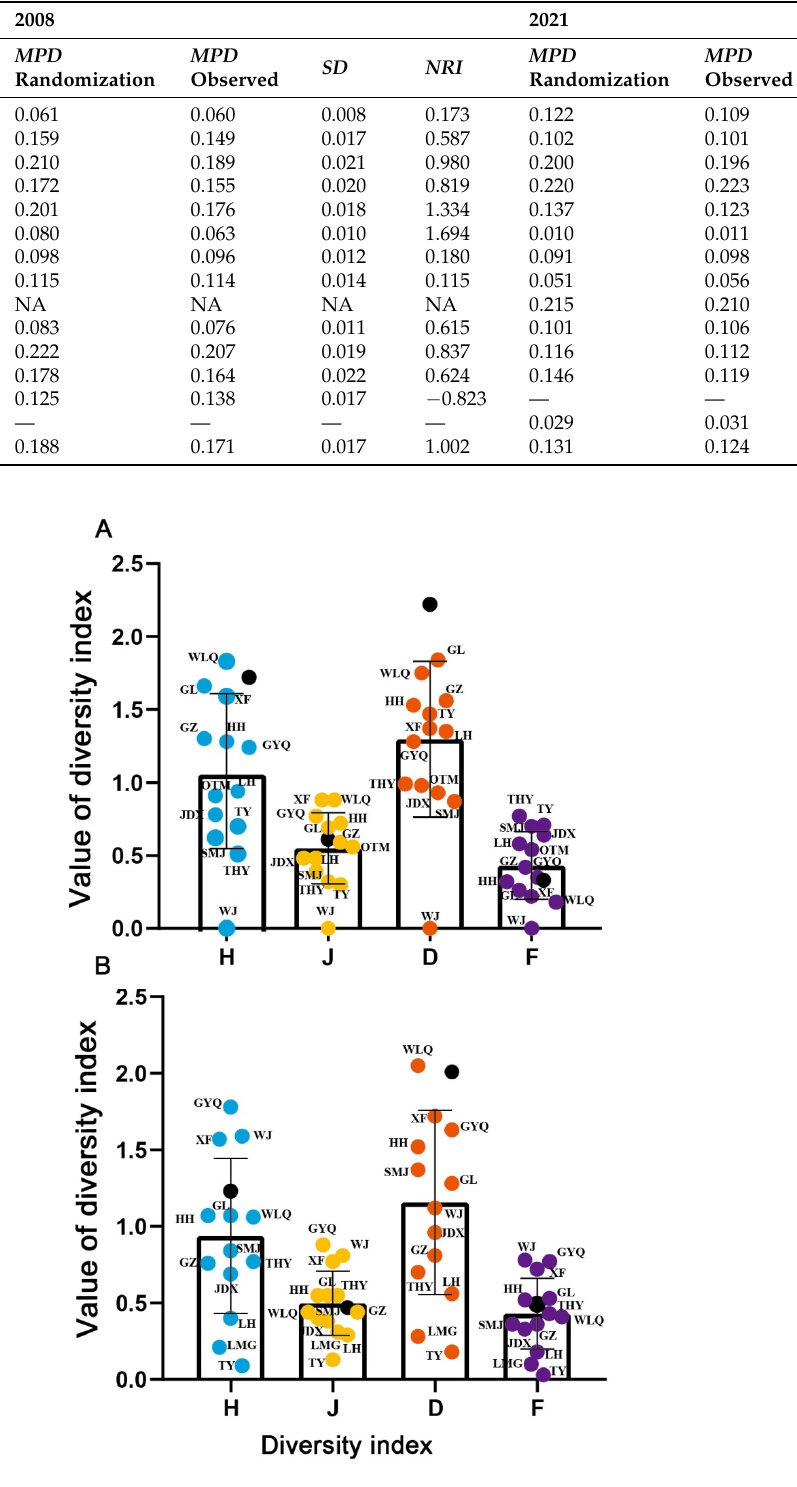
Figure 2. Temporal and spatial change in the diversity of fish in the Lushan National Nature Reserve in 2008 ( A ) and 2021 ( B ). River codes are the same as in Table 1. Blue, orange, red, and purple circles represent the H , J , D , and F , respectively. H : Shannon–Weiner index; D : Margalef diversity index; F : Simpson dominance index; J : Pielou evenness index. Table 1. The phylogenetic distance ( MPD ) randomization and observed, standard deviation of random values ( SD ) and net relatedness index ( NRI ) of fish in the Lushan National Nature Reserve in 2008 and 2021.